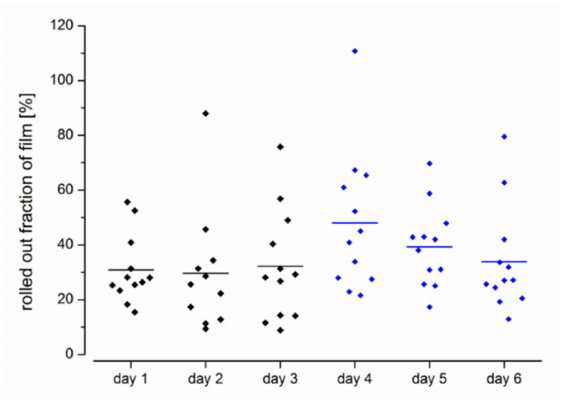
Figure 3. Unrolled film length from the EsoCap system after administration by healthy